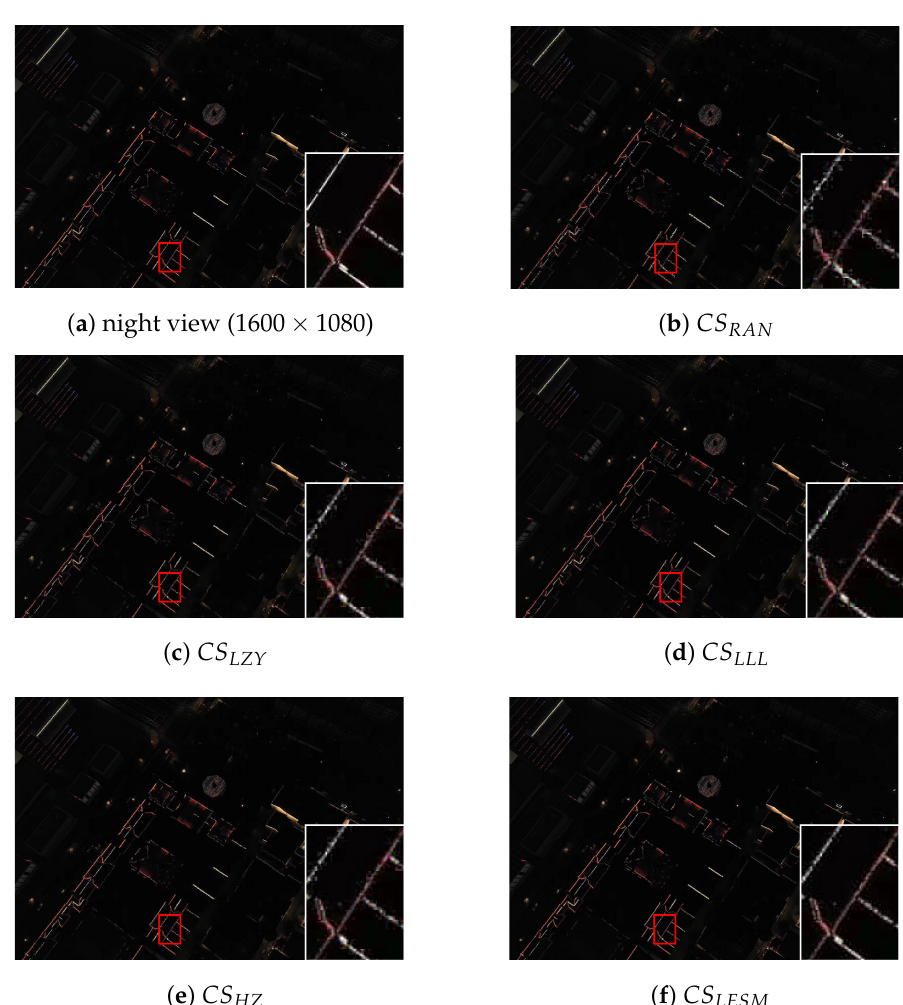
Figure 4. Recovery results for the UAV image "night view" taken by ourselves with no adding noise. ( a ) is the original image, ( b ) is the CS RAN algorithm, ( c ) is the CS LZY algorithm, ( d ) is the CS LLL algorithm, ( e ) is the CS HZ algorithm, and ( f ) is the CS LESM